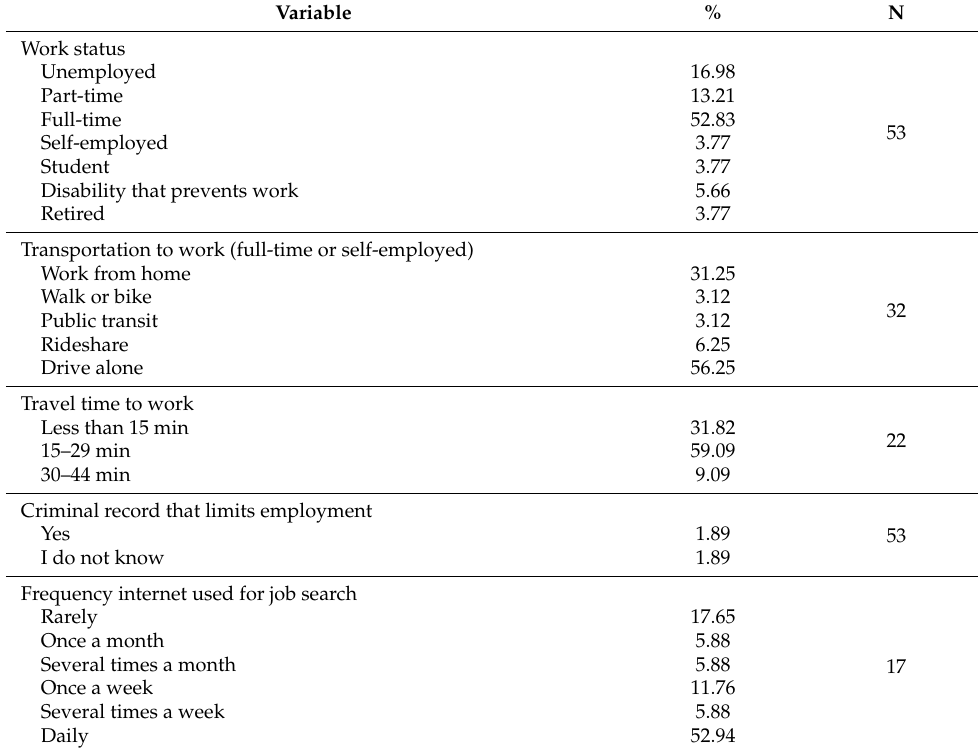
Table 3. Respondents’ Workforce